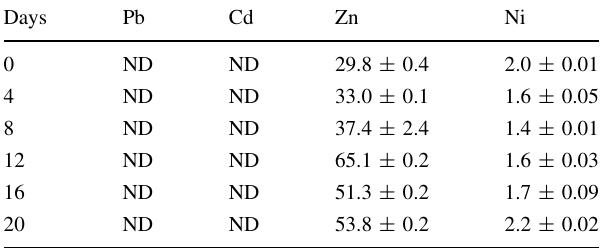
Table 4 DTPA-extractable metal concentrations (mg/kg dry matter) Table 5 TCLP-leachable metal concentrations (mg/kg dry